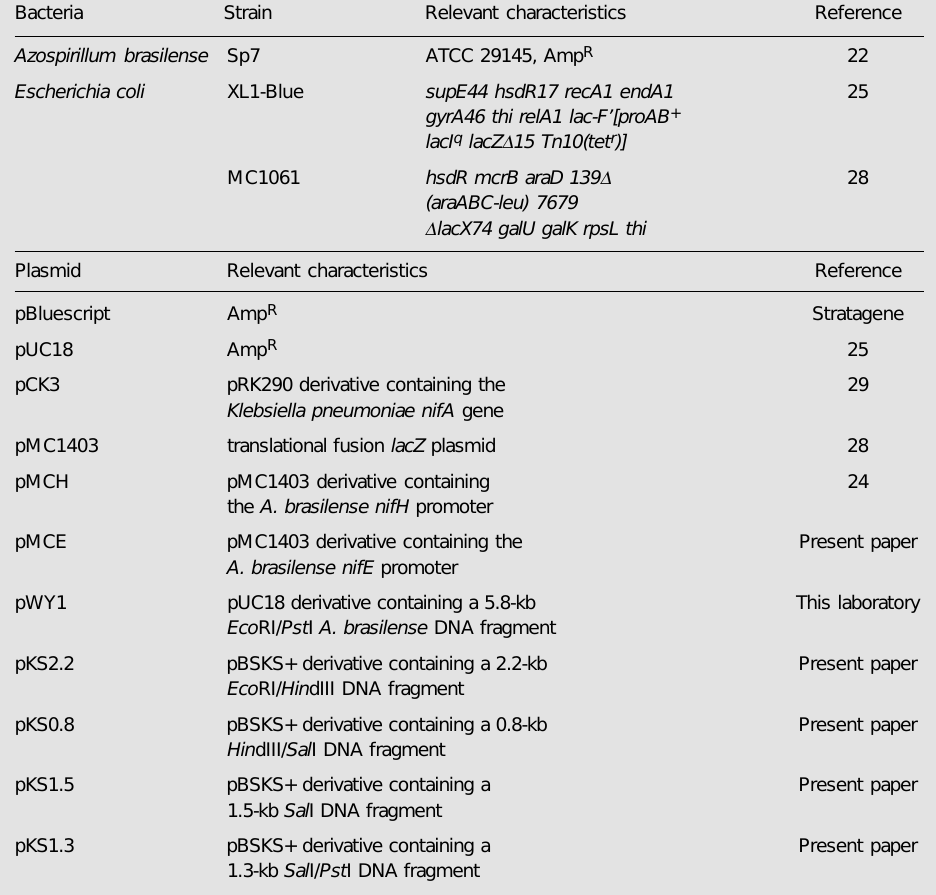
Table 1. Bacterial strains and plasmids used in the present study. Bacteria Strain Relevant